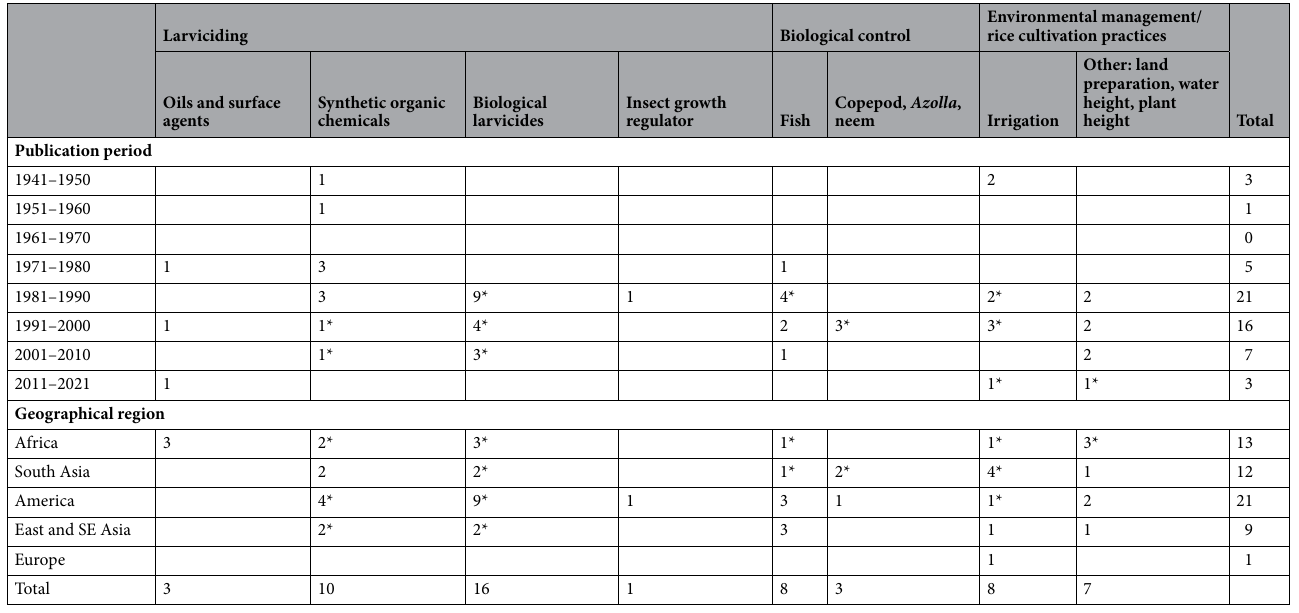
Table 1. Interventions tested by studies included in the qualitative and quantitative analysis (n = 47* studies), stratified by publication period and geographical region. *Studies with multiple comparisons that are treated separately here: Allen et al. 48 , Bolay and Trpis 44 , Djegbe et al. 38 , Kramer et al. (1988), Palchick and Washino 36 , Rajendran and Reuben 45 , Rao et al. 68 , Teng et al. (2005), and Yu et al.